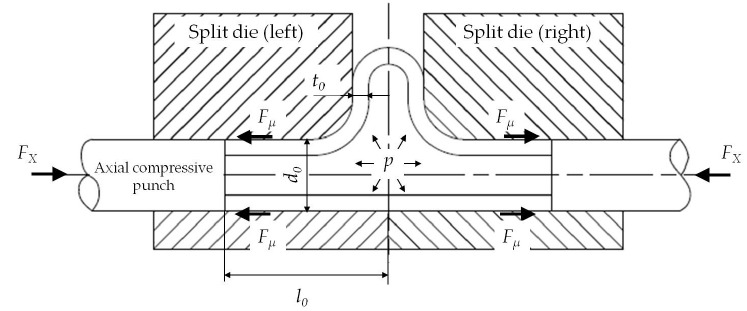
Figure 20. Axial compressive force acting against friction between tube and die F μ during processing.